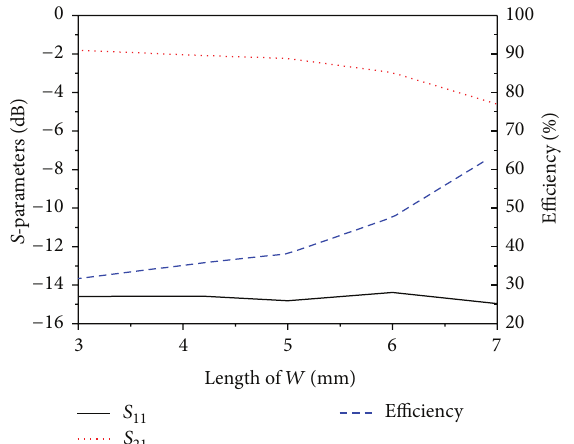
Figure 3: Axial ratio of the SIW leaky-wave antenna as function of length 𝑊 of the N-shaped slot for 𝑓 = 8 GHz, 𝐿 = 5 mm, 𝐿 1 = = 3.2 4 mm, and 𝑊 1